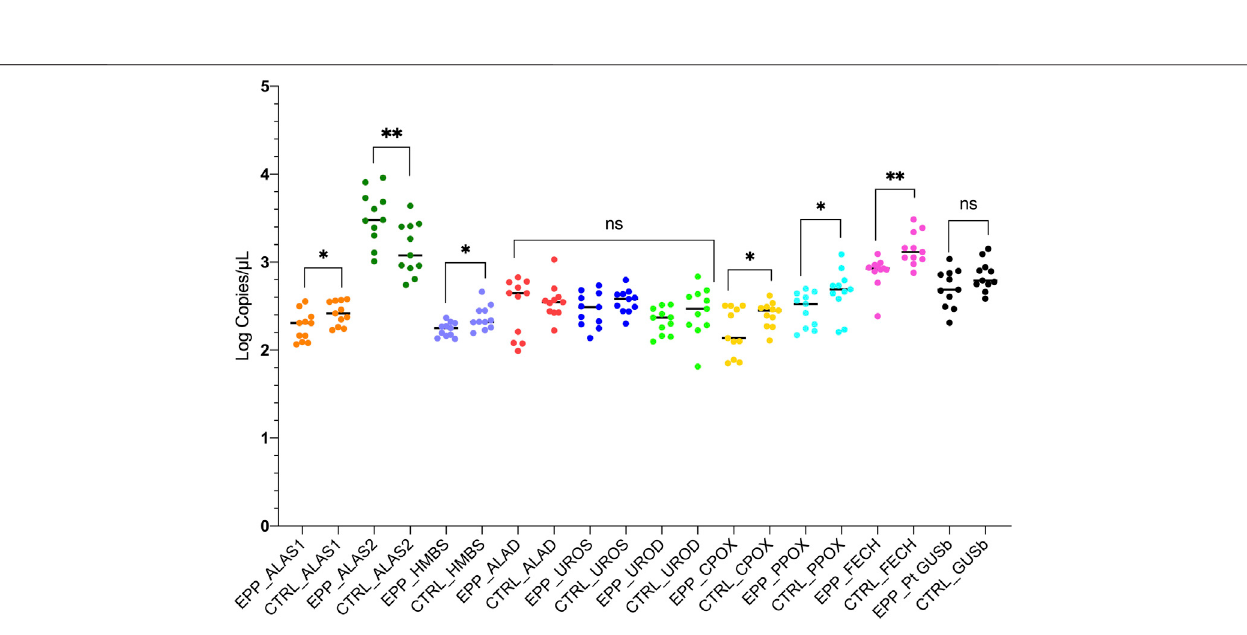
Frontiers in Physiology |